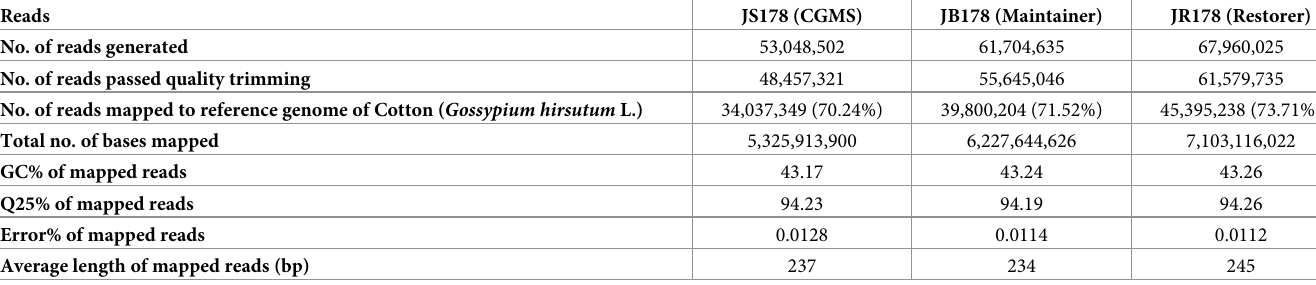
Table 2. Quality screening and mapping statistics of RNA-Seq